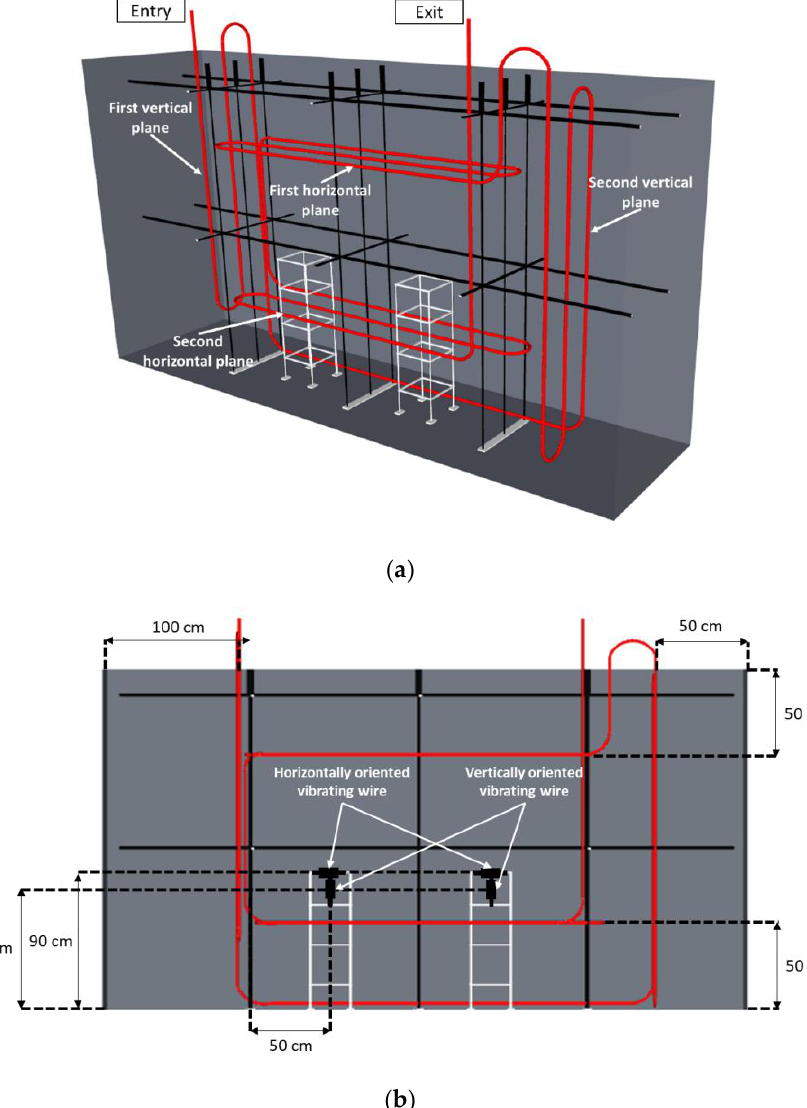
Figure 7. ( a ) Instrumentation scheme of NRC blocks with embedded DOFS; ( b ) Projection view showing the horizontal/vertical positions of the embedded DOFS and vibrating wire sensors.